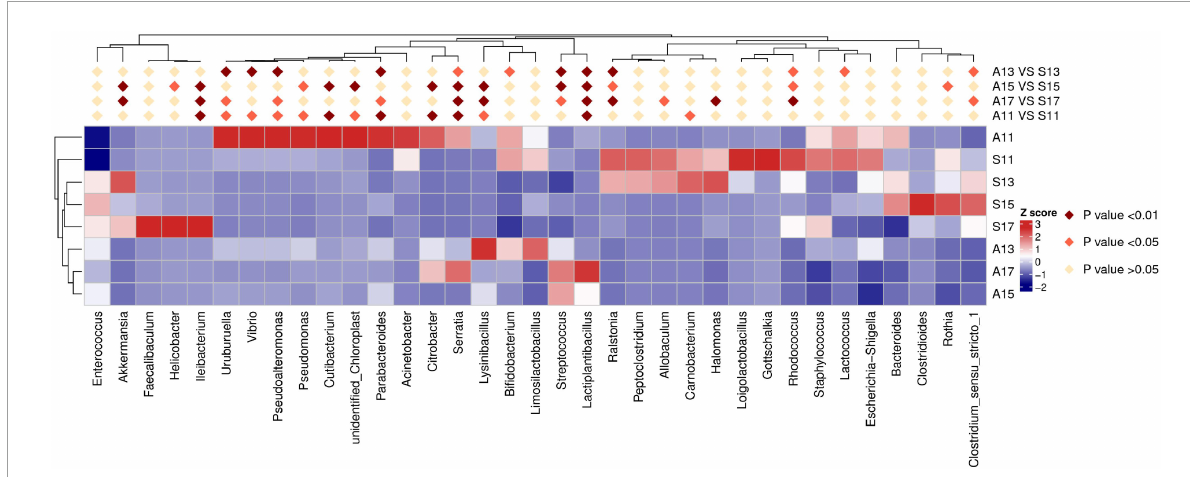
FIGURE2 Results of heatmap analysis of species with significant differences between the SGA and AGA groups at the genus level. S11, gut microbiota of the SGA group on day 1; A11, gut microbiota of the AGA group on day 1; S13, gut microbiota of the SGA group on day 3; A13, gut microbiota of the AGA group on day 3; S15, gut microbiota of the SGA group on day 5; A15, gut microbiota of the AGA group on day 5; S17, gut microbiota of the SGA group on day 7; A17, gut microbiota of the AGA group on day 7.